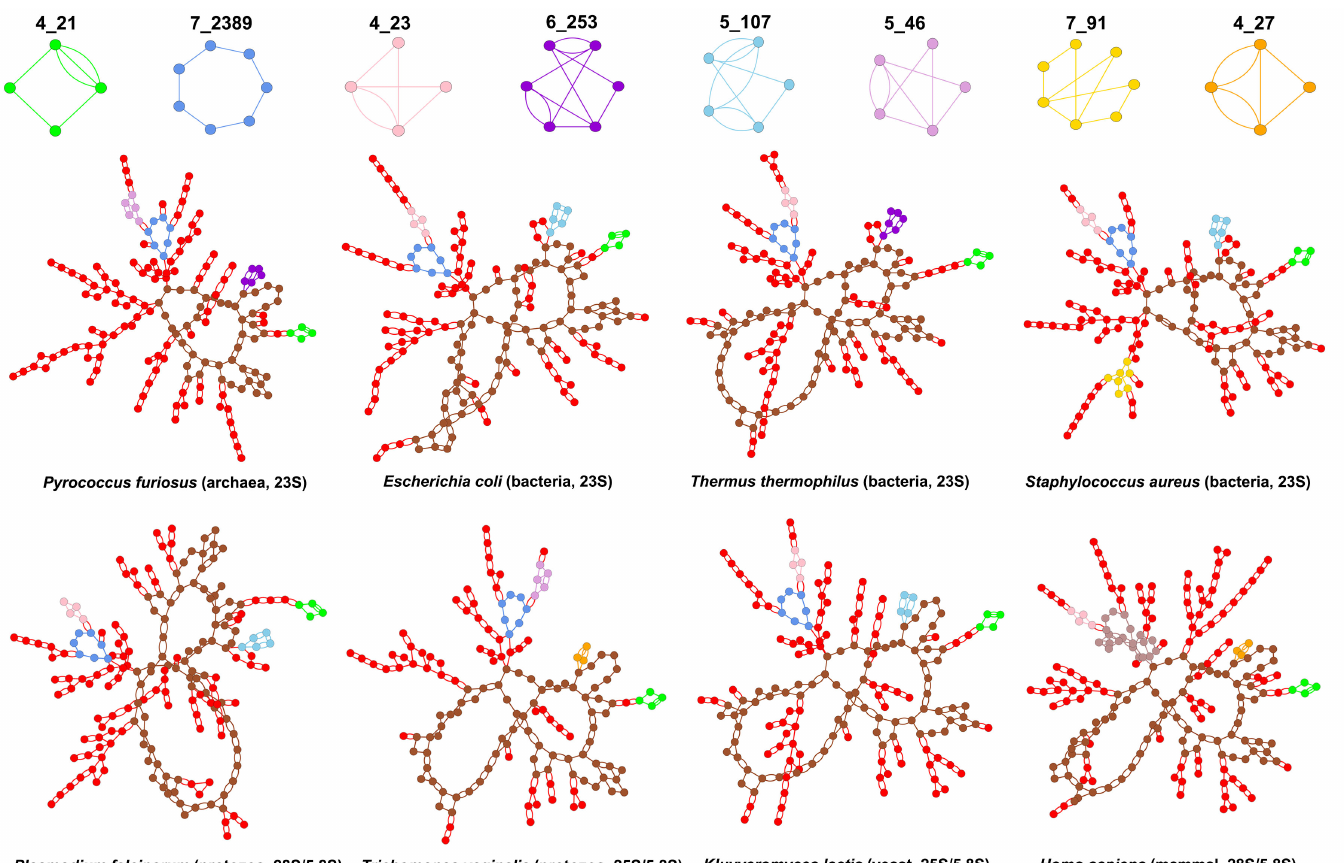
Figure 8. Dual graphs for large subunit rRNAs. Dual graphs corresponding to the 23S (prokaryotes) and 25–28S/5.8S (eukaryotes) rRNAs of large ribosomal subunits for a few representative species. Different colors highlight different subgraph blocks. The subgraph blocks with > 40 vertices are shown in brown. The 21-vertex subgraph in Homo sapiens in shown in light brown. Smaller subgraphs that occur in large numbers (2_2, 3_5, 4_19, 5_2, and 2_1) are all colored red and not highlighted